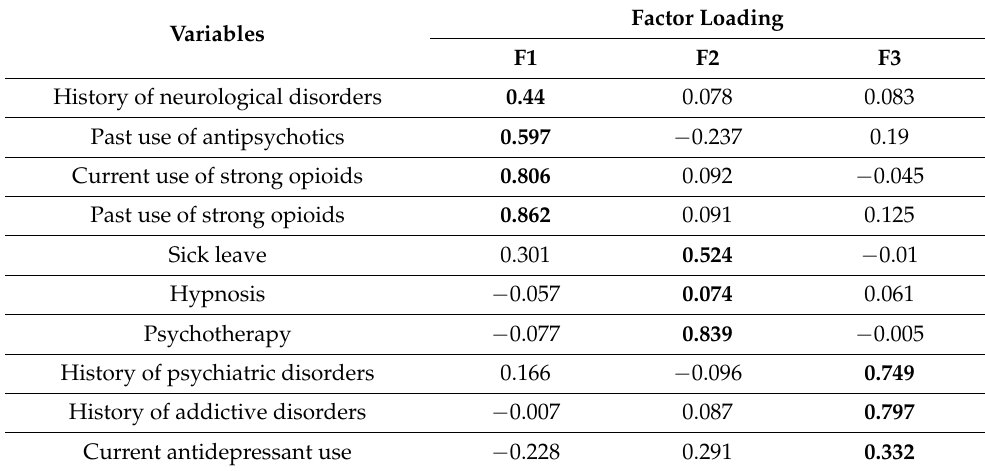
Table 6. Factors associated with p-OUD according to the principal component